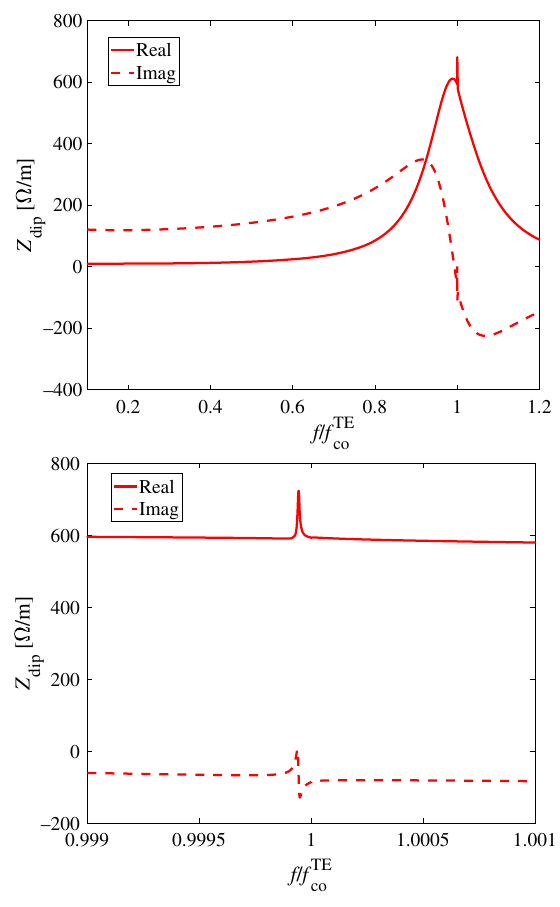
FIG. 9. Perturbation of the dipolar impedance by a trapped mode close to the TE 11 cutoff frequency (top) and enlarged view around cutoff (bottom). Mode matching parameters: b ¼ 10